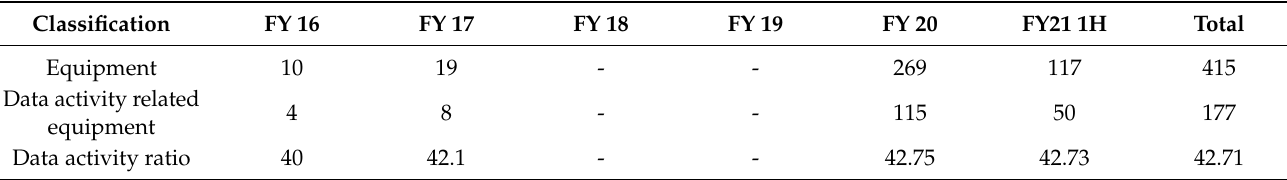
Table 8. Details of data activity ratio calculation for the